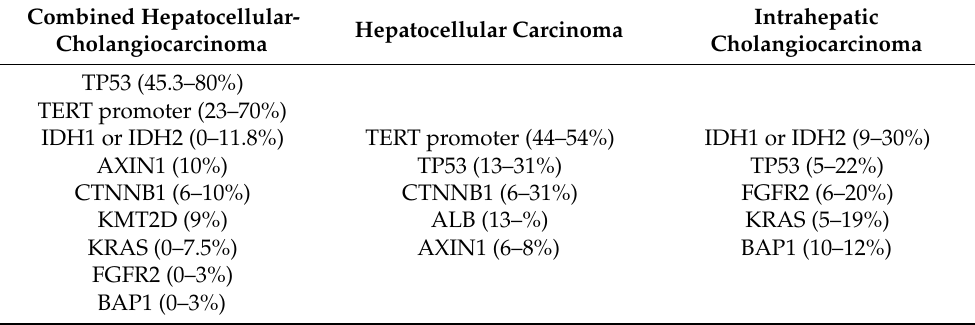
Important molecular mutations and their frequencies in combined hepatocellular- cholangiocarcinoma, hepatocellular carcinoma and intrahepatic cholangiocarcinoma [9,56–60]. Dif- ferences in reported frequencies are likely due to cohorts from various populations. TP53, tumour protein 53; TERT, telomerase reverse transcriptase; AXIN1, axis inhibition protein 1; KMT2D, lysine methyltransferase 2D; CTNNB1, catenin beta 1; KRAS, Kirsten rat sarcoma viral oncogene homolog; IDH1, isocitrate dehydrogenase 1; IDH2 isocitrate dehydrogenase 2; FGFR2, fibroblast growth factor receptor 2; BAP1, BRCA1-associated-protein 1; ALB, albumin. Combined